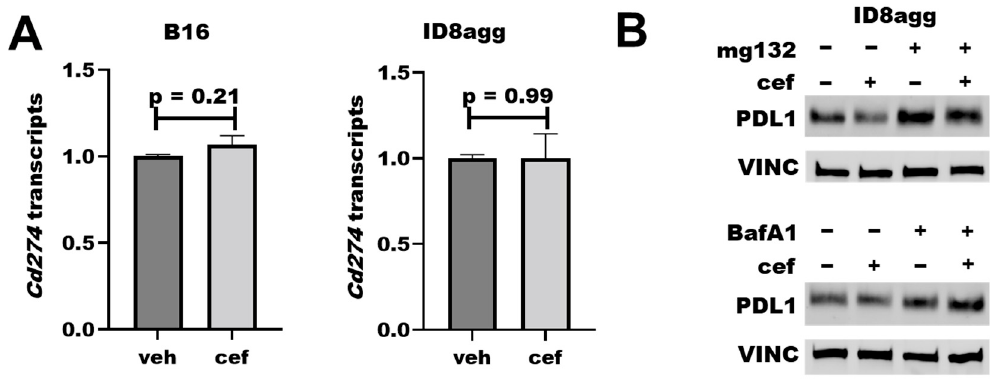
Figure 6. Cefepime regulates tumor PDL1 post-translationally. (A ) RT-qPCR assessment of normalized Cd274 gene expression of B16 and ID8agg cells treated with DMSO (veh) or 80 μ M cefepime (cef) for 48 and 24 h, respectively. ( B ) Western blot of ID8agg cells treated with 0.2 μ M mg132 for final 6 h, 100 nM bafilomycin A1 (BafA1) for final 6 h, and/or 80 μ M cefepime for 48 h for PDL1 and loading control vinculin (VINC).